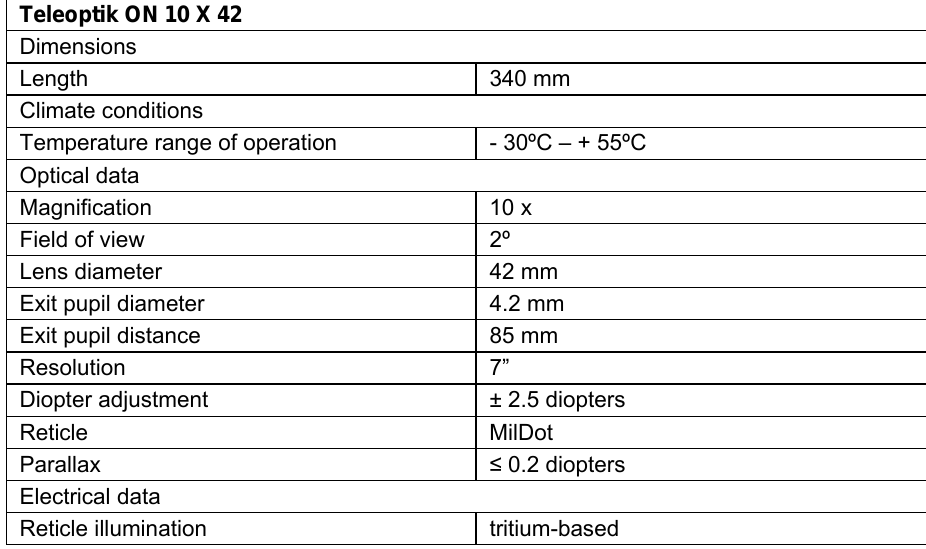
Table 4 – Technical-technological characteristics of the Teleoptik ON-10 x 42 optical